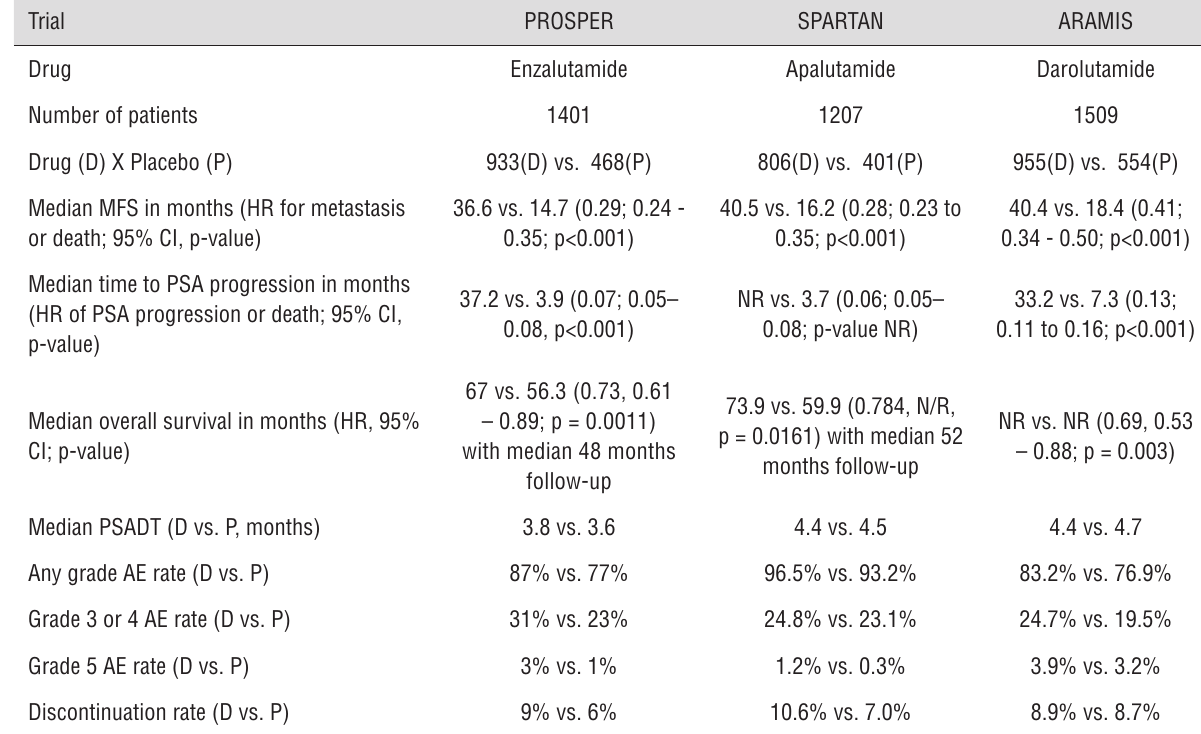
Table 1 - PROSPER vs. SPARTAN vs.